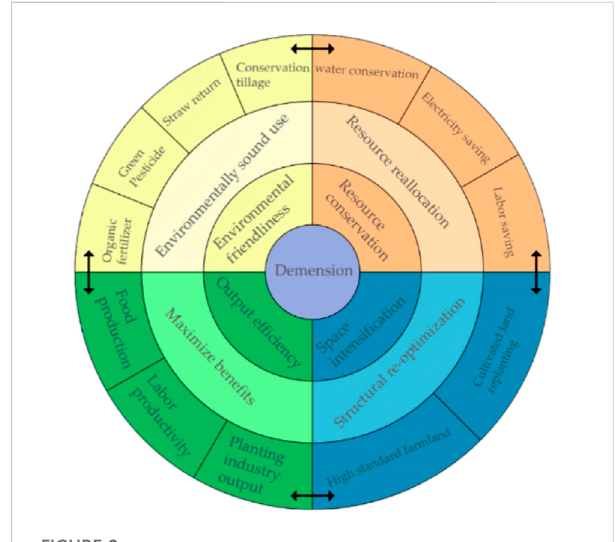
FIGURE 2 Green use of cultivated land concept diagram.